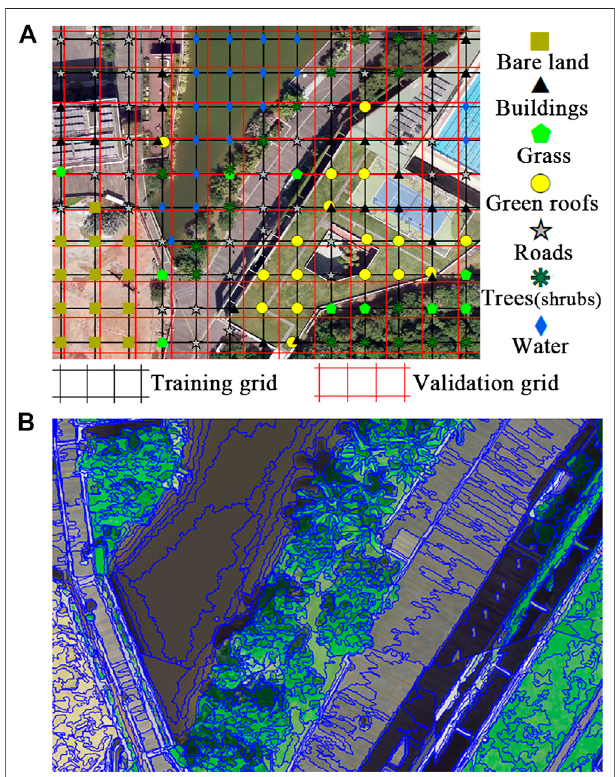
FIGURE 3 | (A) Chessboard grid sampling method for making samples. The dots are sample points at the grid intersections. (B) Objects created by multiresolution segmentation, shown as blue